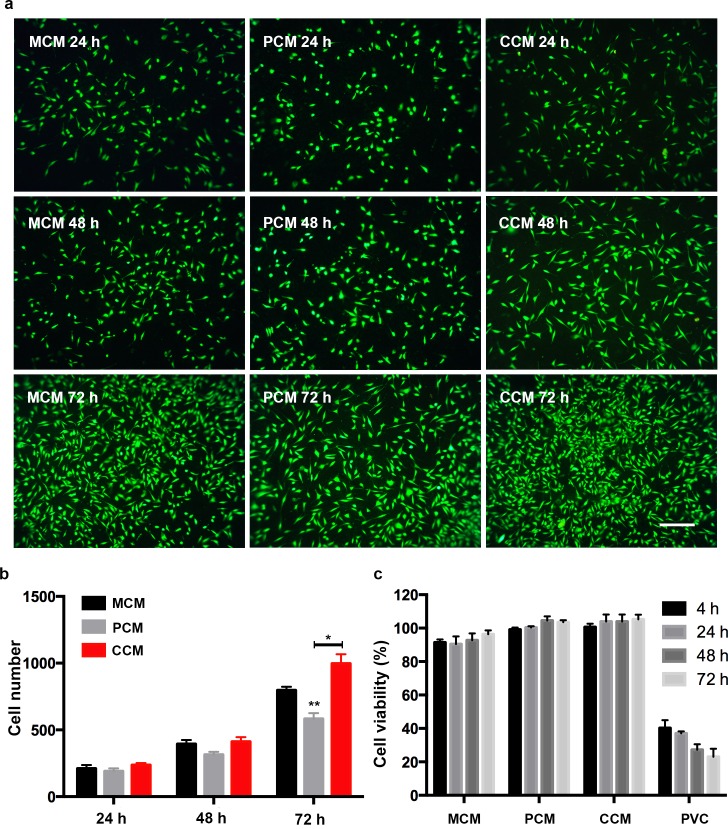
NIH-3T3 cell proliferation assay on MCM, PCM and CCM.(a) Fluorescence pictures that cells were cultured in three different matrix at 24, 48 and 72 h. (b) The number of NIH-3T3 cells adhered to the surface of materials at 24 h, 48 h and 72 h. (c) The cell viability of each test group (different leaching solution) at each observation time point. Scale bars: 100 μm. *: 0.01<P<0.005. **: 0.001<P<0.01.